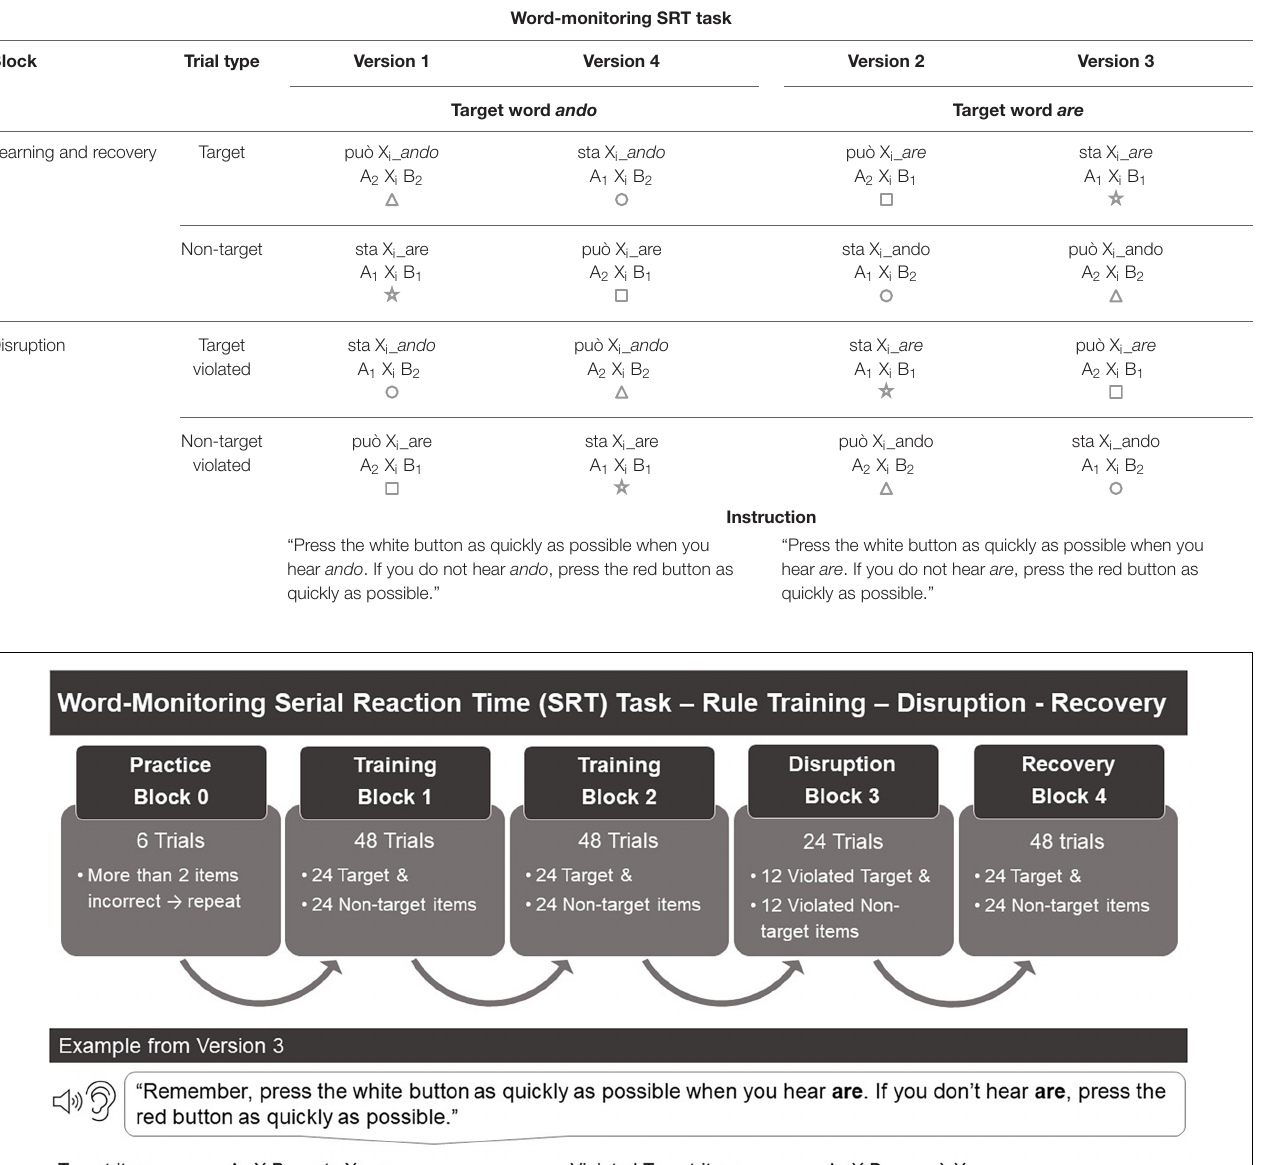
TABLE 3 | Trial types and their use within blocks and each version of the word-monitoring SRT task.